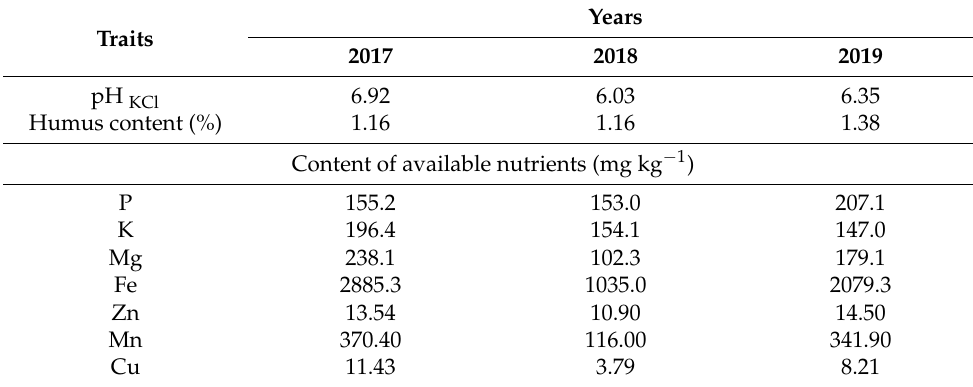
Table 2. Soil characterization before soybean sowing.